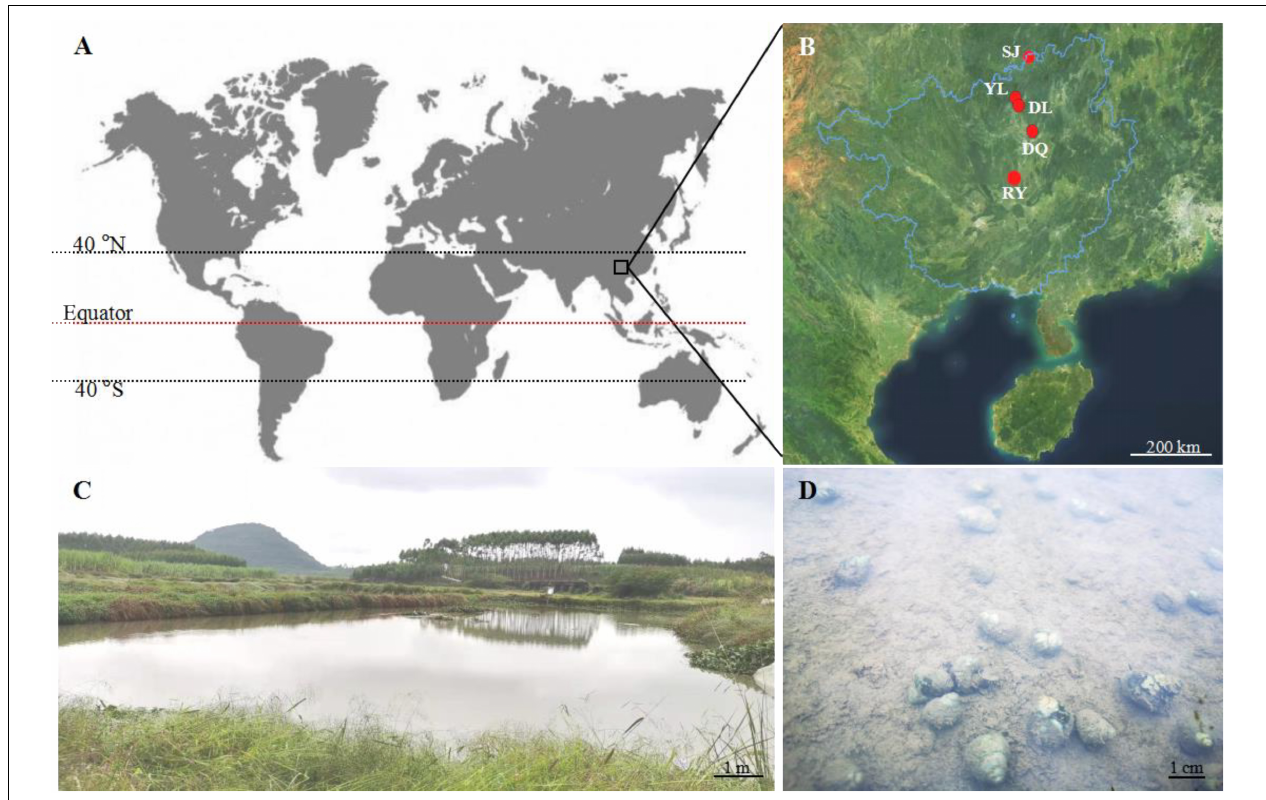
FIGURE 1 | Geographical location of Bellamya spp. snail shell collection. (A) The location of the collection site on the world map; (B) the geographical location of the five aquatic areas where snail shells were collected; (C) the aquatic environment of YL; (D) the eroded snail in the aquatic water of YL; SL, Sanjiang County (25 ◦ 56 (cid:48) 36 (cid:48)(cid:48) N, 109 ◦ 28 (cid:48) 41 (cid:48)(cid:48) E); YL, Yongle Town (25 ◦ 2 (cid:48) 7 (cid:48)(cid:48) N, 109 ◦ 8 (cid:48) 4 (cid:48)(cid:48) E). DL, Dongliang Village (25 ◦ 0 (cid:48) 54 (cid:48)(cid:48) N, 109 ◦ 13 (cid:48) 29 (cid:48)(cid:48) E); DQ, Dongquan Town (24 ◦ 32 (cid:48) 30 (cid:48)(cid:48) N, 109 ◦ 33 (cid:48) 13 (cid:48)(cid:48) E); RY, Renyi Village (23 ◦ 43 (cid:48) 56 (cid:48)(cid:48) N, 108 ◦ 55 (cid:48) 32 (cid:48)(cid:48) E).